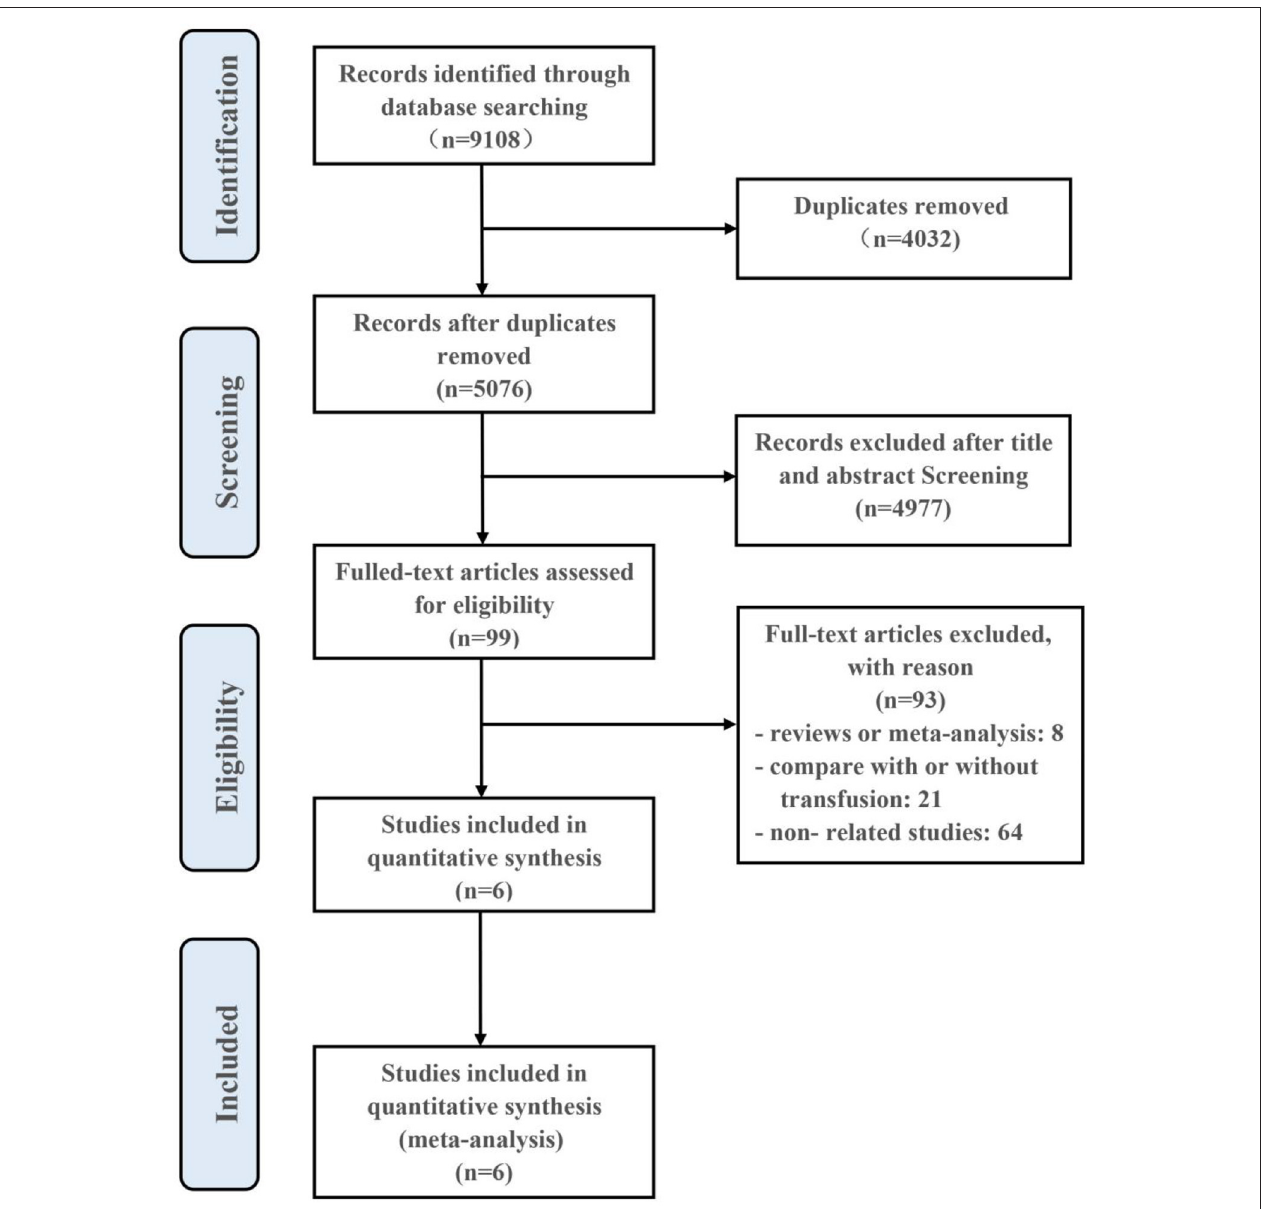
FIGURE 1 | The flow diagram indicated the process of study